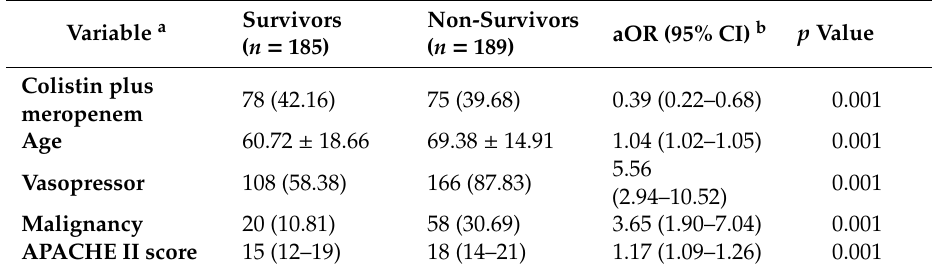
Table 4. Multivariable logistic regression model for significant predictors of risk factors for 30-day mortality among all patients with CRAB